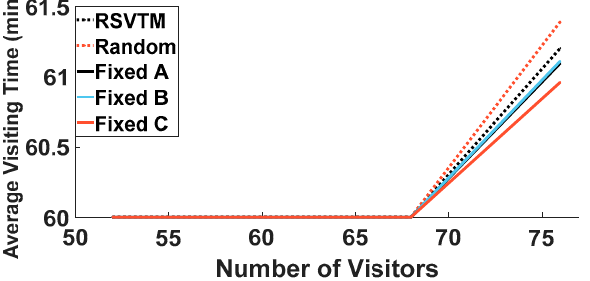
Figure 9. Average visiting time as a function of the number of visitors for all the comparative scenarios.